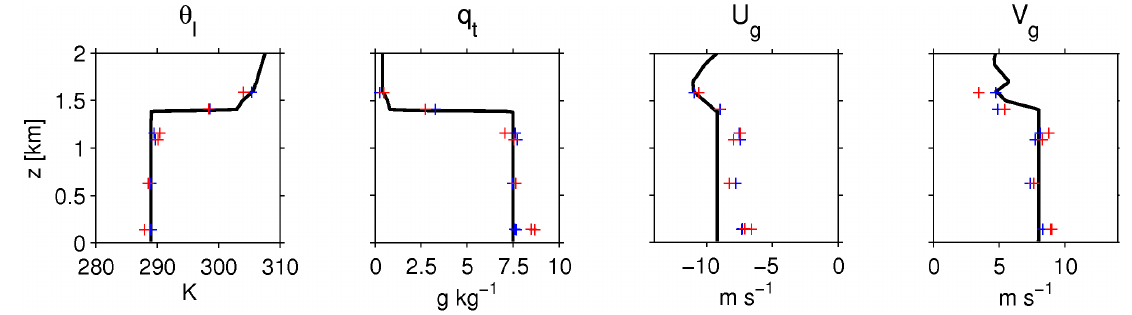
Fig. 2. Profiles used to initialize the LES. The geostrophic wind profiles are used as steady forcings as well as initial conditions. Only heights less than 2 km are shown. Observations from RF06 are overlaid, blue from within the OVC, red from within the POC.